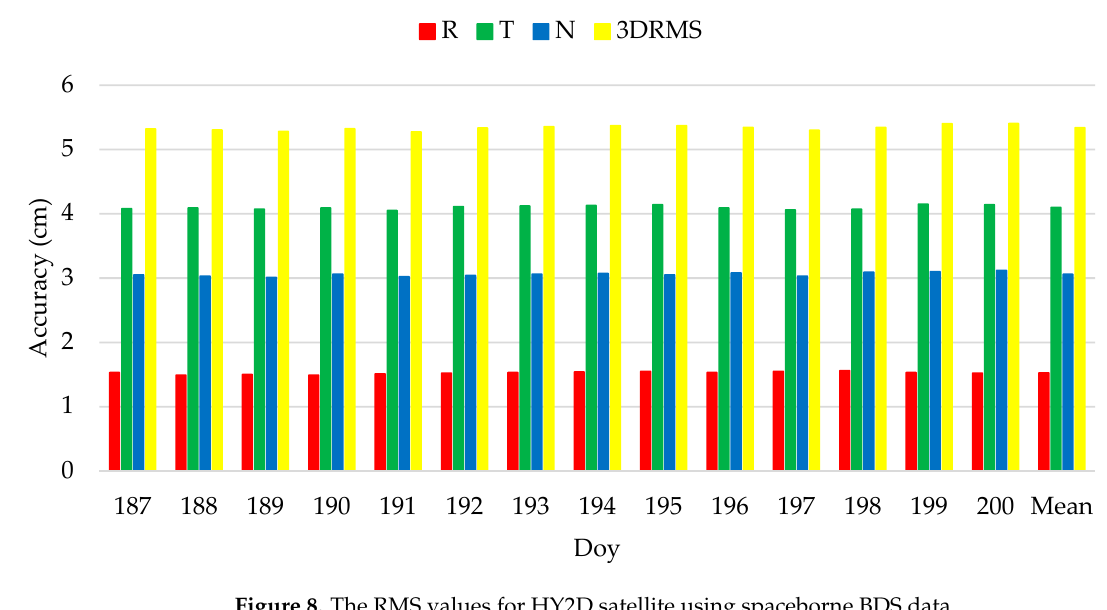
Figure 8. The RMS values for HY2D satellite using spaceborne BDS data.